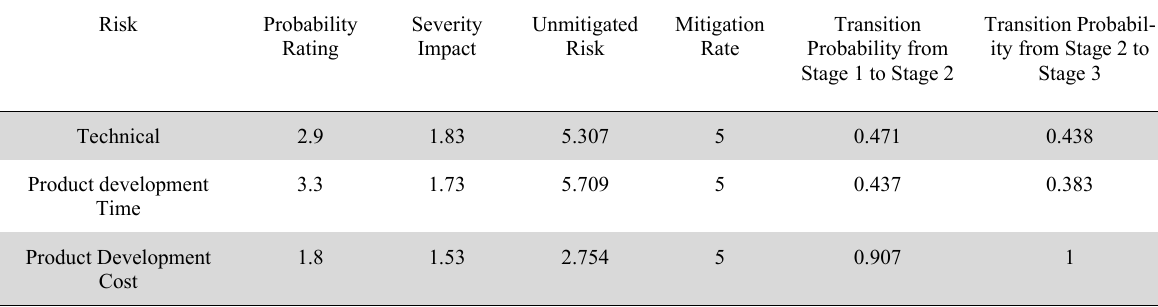
Risk associated with transition in initial stages